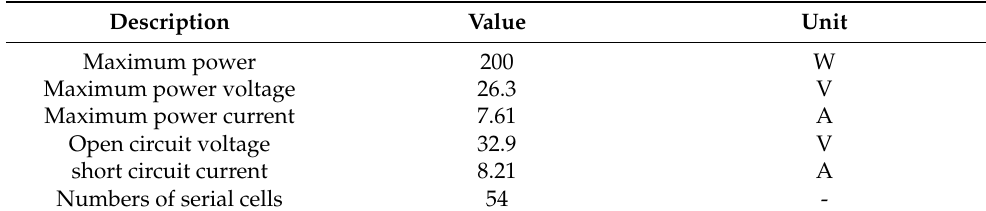
Table 2. The parameters of the KC200GT solar panel.